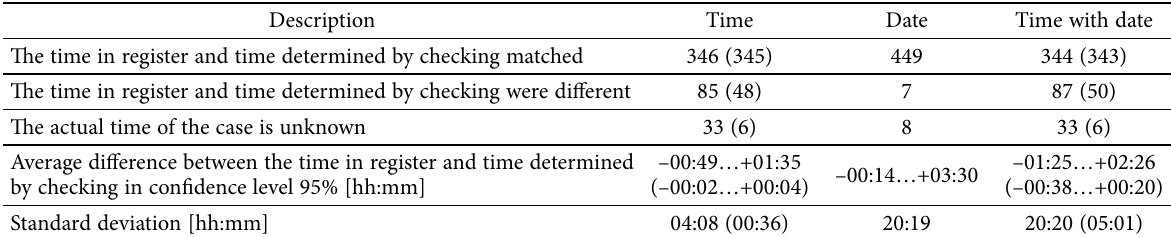
Table 1. Difference in the data of cases obtained from the MTPL database statement and the inspection (the figure in brackets does not consider cases with default